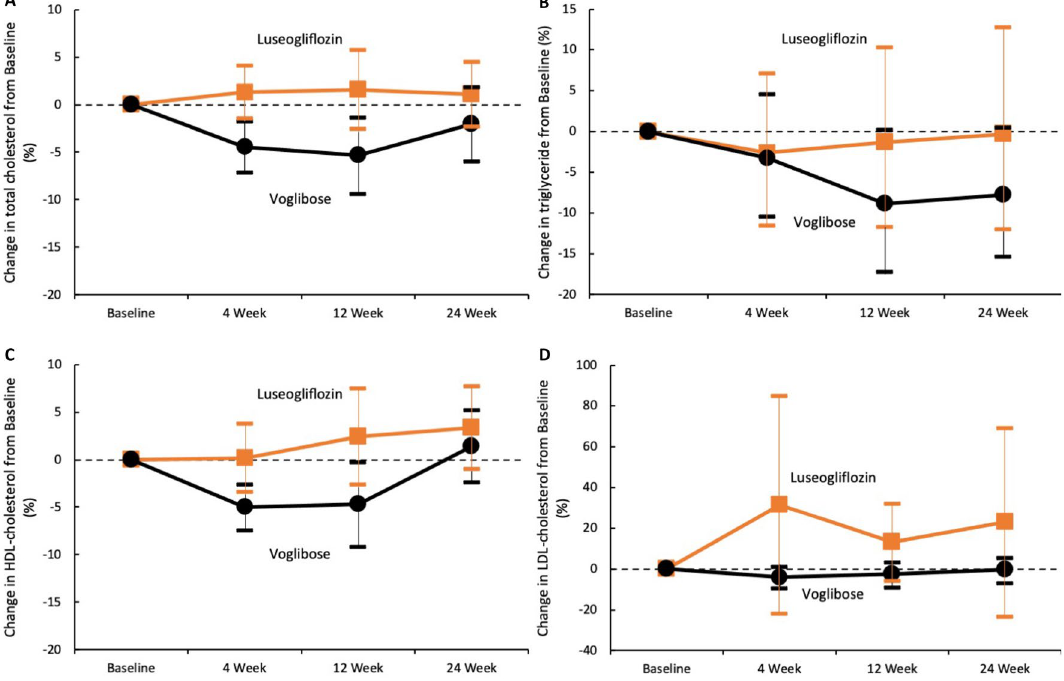
Figure 3. Change in the lipid profile from baseline. The orange squares and lines (luseogliflozin group) or black circles and lines (voglibose group) indicate the mean changes and 95% confidence intervals of each marker, relative to the baseline. Each value is represented in Table 2. LDL low-density lipoprotein, HDL high-density